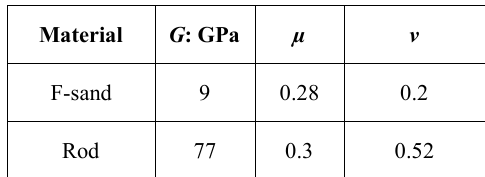
Table 1. DEM contact model parameters.